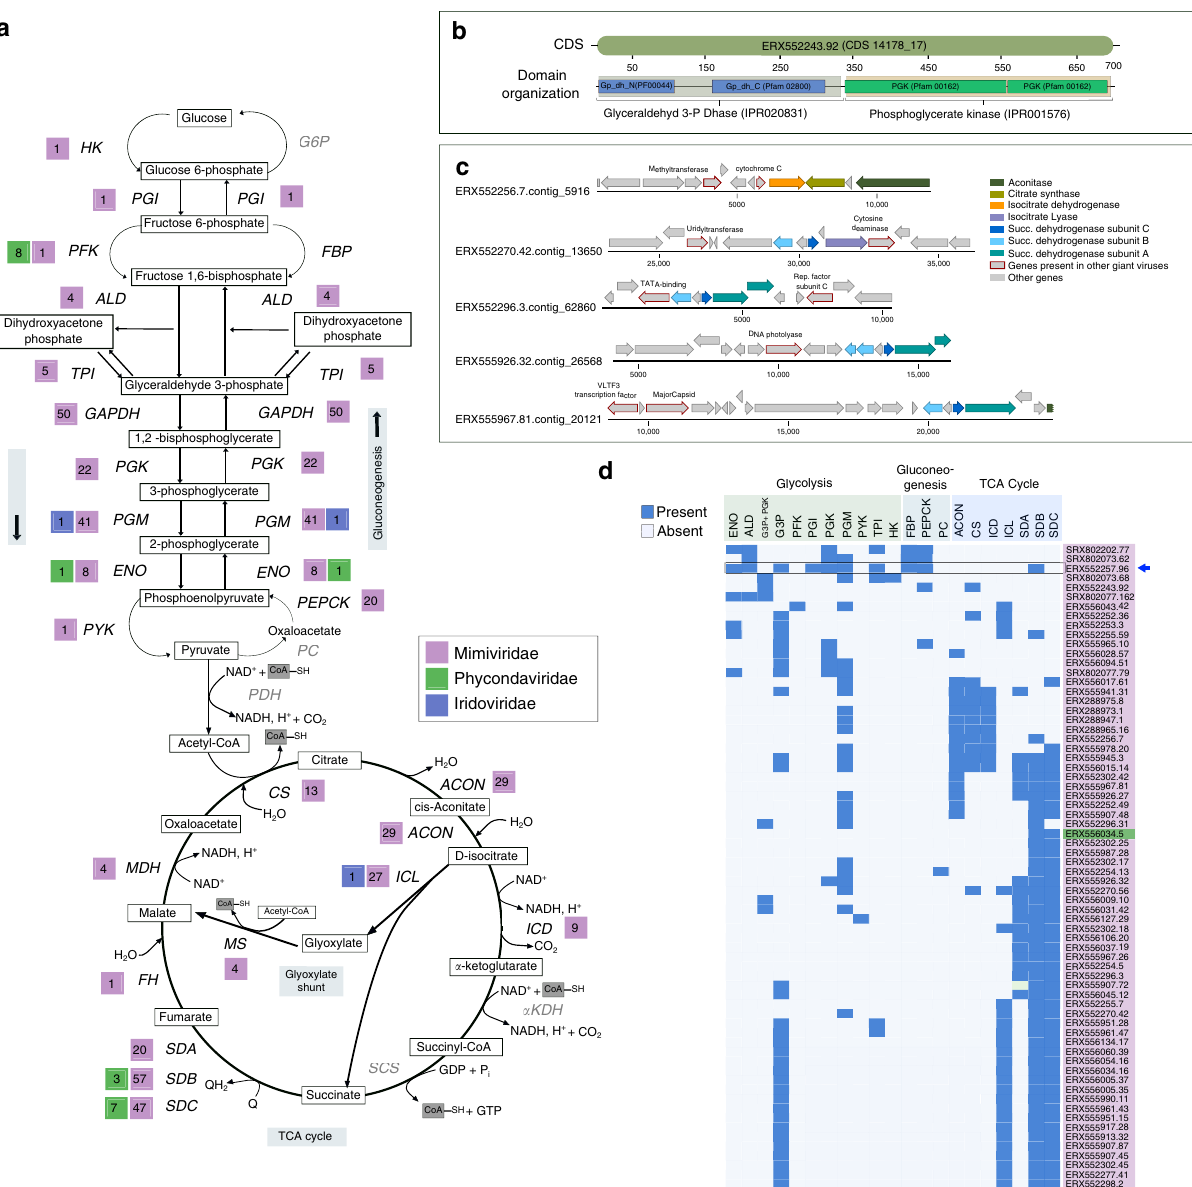
Fig. 4 Presence of central carbon metabolic enzymes in the NCLDVs. a Schematic of Glycolysis, Gluconeogenesis, and the TCA cycle, with the number of NCLDV MAGs harboring a particular enzyme provided beside abbreviated enzyme names. Enzymes that were not detected in any of the studied NCLDVs are in gray. b Representative CDS from genome ERX552243.92 illustrating the domain organization (PFAM and Interpro) of the fused-domain gene (G3P + PGK) involved in glycolysis, that was detected in 16 of the NCLDV MAGs. c Example of co-localization of genes involved in TCA cycle on genomic contigs from fi ve representative NCLDV MAGs. Location of a number of other genes commonly present in NCLDVs are also shown. d Presence/absence of genes involved in central-carbon metabolism in NCLDV genomes assembled in this study. Only the genomes harboring 3 or more enzymes are shown. G3P + PGK indicates the fused-domain gene illustrated in panel B. Blue arrow indicates the genome that harbors 7 out of 10 enzymes involved in glycolysis. HK: hexokinase, PGI: Phosphoglucoisomerase, PFK: Phosphofructokinase, ALD: aldolase, TPI: Triose-phosphate isomerase, G3P: Glyceraldehyde 3- phosphate dehydrogenase, PGK: Phosphoglycerate kinase, PGM: Phosphoglycerate mutase, ENO: Enolase, PYK: Pyruvate kinase, PEPCK: PEP carboxykinase, FBP: Fructose 1,6-bisphosphatase, G6P: Glucose 6-phosphatase, PDH: Pyruvate dehydrogenase, PC: Pyruvate carboxylase, CS: Citrate synthase, ACON: Aconitase, ICL: Isocitrate lyase, ICD: Isocitrate dehydrogenase, α KDH: α -ketoglutarate dehydrogenase, SCS: Succinyl-CoA synthetase, SD: Succinate dehydrogenase (subunits A, B and C), FH: Fumarate hydratase, MS: Malate synthase, MDH: Malate